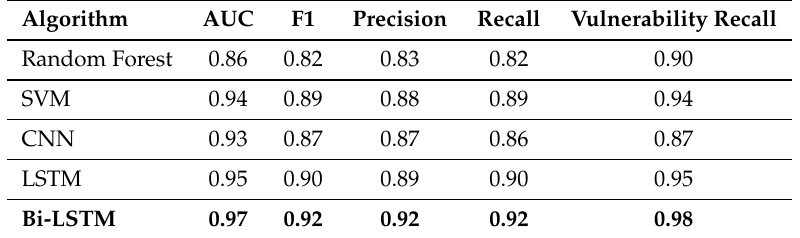
Table 5. Performance of different algorithms.